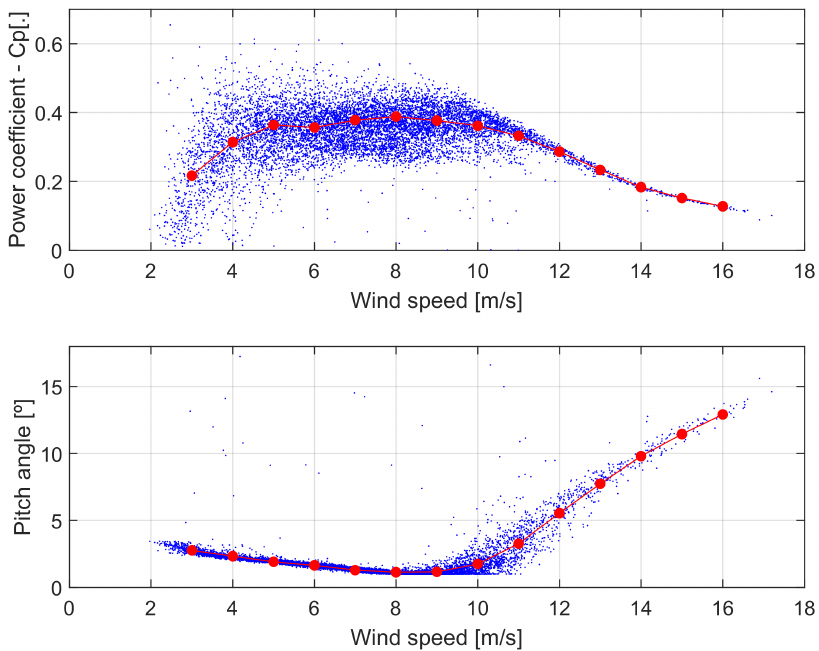
Figure 1. Power coefficient and blade pitch angle as a function of the wind speed for the 2.5 MW Liberty C96 wind turbine obtained from SCADA data. The 10 min values are shown in blue dots and binned averages in red. A quasi constant power coefficient is observed for wind speeds from 5 to 10